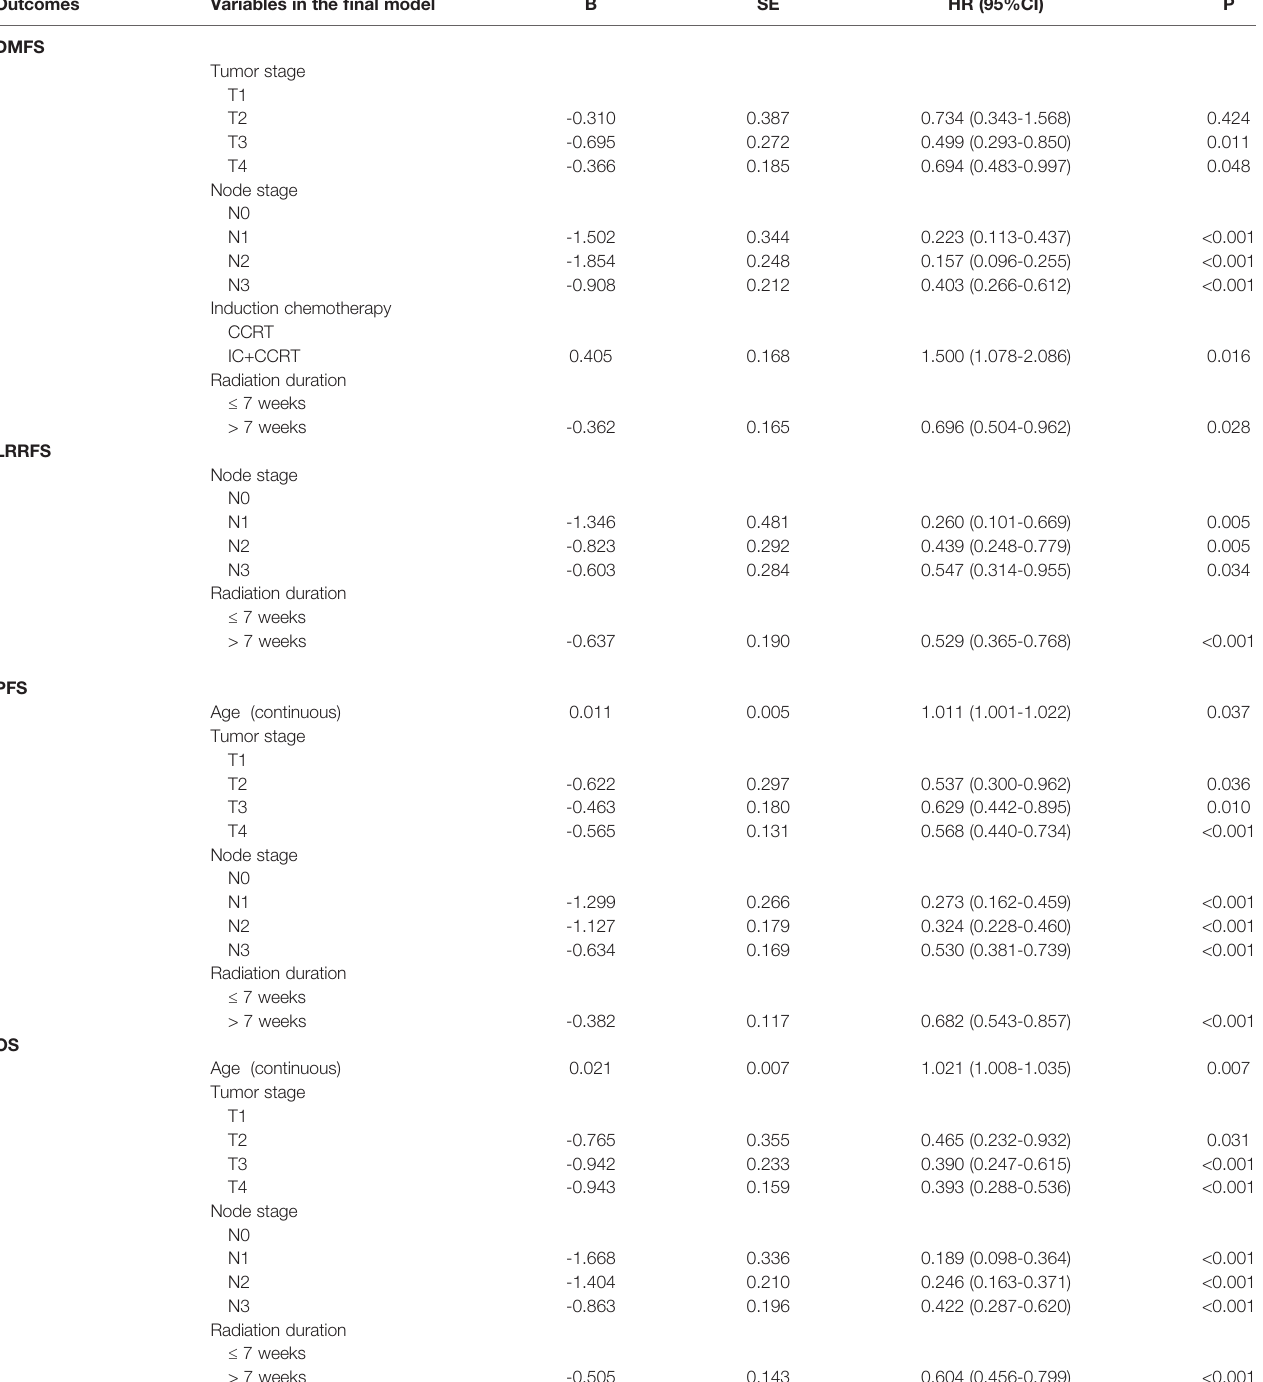
TABLE 3 | Multivariate analyses of factors based on the Cox regression